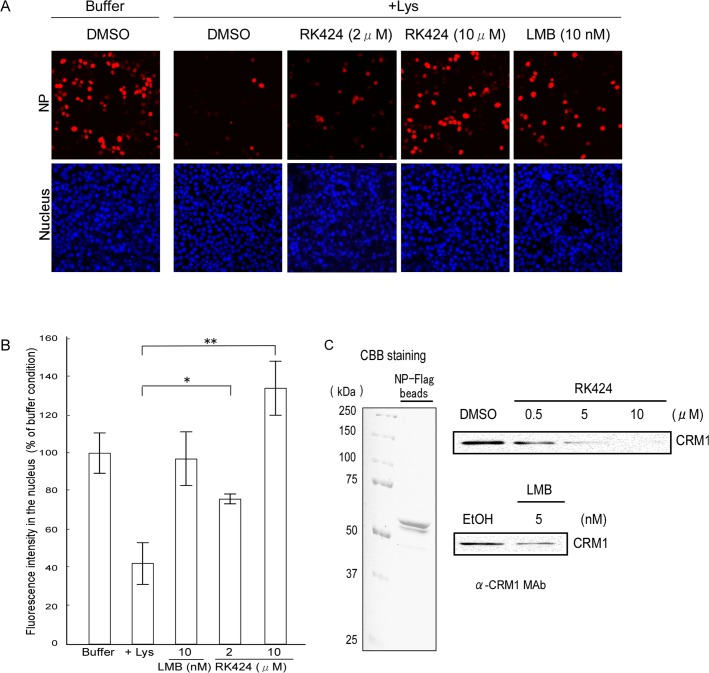
Effect of RK424 on nuclear export of NP and the binding of NP to CRM1.(A) In vitro nuclear export assay incorporating NP-mRFP-Flag. Cells expressing NP-mRFP-Flag were permeabilized with digitonin and incubated for 1 h without (Buffer) or with HeLa cell lysate (+Lys) in the presence of the RK424 at the indicated concentrations (upper panels). Leptomycin B (LMB) was used as a positive control (LMB inhibits nuclear export of NP). Nuclei were stained with Hoechst 33342 (lower panels). The export of NP-mRFP-Flag was monitored by measuring mRFP fluorescence in the nucleus. Three independent experiments were performed and one representative result is shown. (B) Quantification of mRFP fluorescence in the nucleus. The nuclear localization of NP-mRFP-Flag was determined by monitoring mRFP fluorescence in the nucleus (> 100 cells). Data are expressed as the mean ± SD of three independent experiments. *;p<0.05 and **;p<0.005. (C) RK424 inhibits the binding of NP-mRFP-Flag to CRM1. FLAG agarose beads coupled to NP-Flag (NP-flag beads) were subjected to SDS-PAGE and the purity of the NP-Flag protein was checked by Coomassie Brilliant Blue (CBB) staining (left panel). HeLa cell lysate was incubated with NP-Flag beads in the absence or presence of RK424 (0.5, 5, or 10 μM). LMB was used as a positive control. Binding of CRM1 to NP was detected by western blotting with an anti-CRM1 MAb (right panel). EtOH and DMSO were used as vehicle controls. The positions of NP-Flag and CRM1 are indicated. Two independent experiments were performed and one representative result is shown.